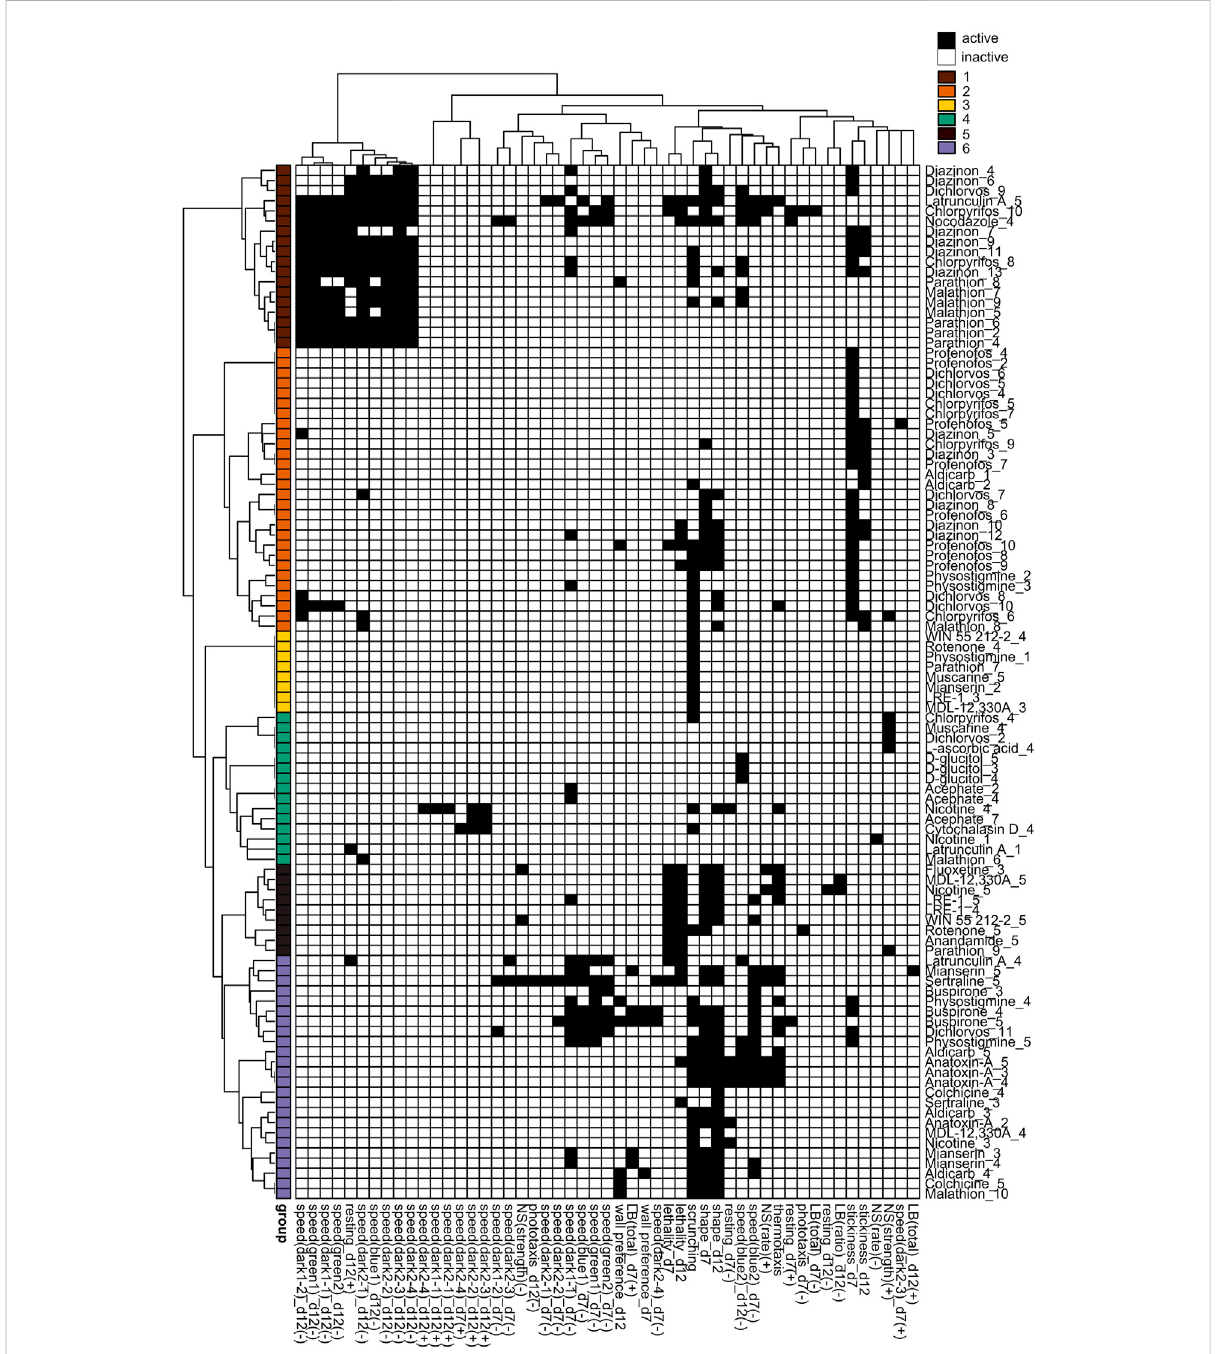
FIGURE 5 Hierarchicalclusteringofadultphenotypicbarcodes.Activeoutcomemeasuresforeachchemicalconcentrationareshowninblack.Outcome measures that can have effects in both directions are separated into either the positive (+) or negative (-) direction. Only active chemical concentrationsandoutcomemeasuresareshown.Numbersinchemicalnamesrefertotherespectivetestconcentration,with1asthelowesttested concentration, see Table 1. Hierarchical clustering was performed using binary distance and Ward ’ s method. Six clusters were identi fi ed with similarphenotypicpro fi les:Cluster1:Strong locomotordefects(reducedspeedandincreasedresting),Cluster2:effectsinprimarilyday7stickiness, Cluster 3: scrunching defects only, Cluster 4: 1 or 2 hits in miscellaneous outcome measures, Cluster 5: lethal/systemic toxicity, Cluster 6: effects in scrunching and body shape with the addition of other